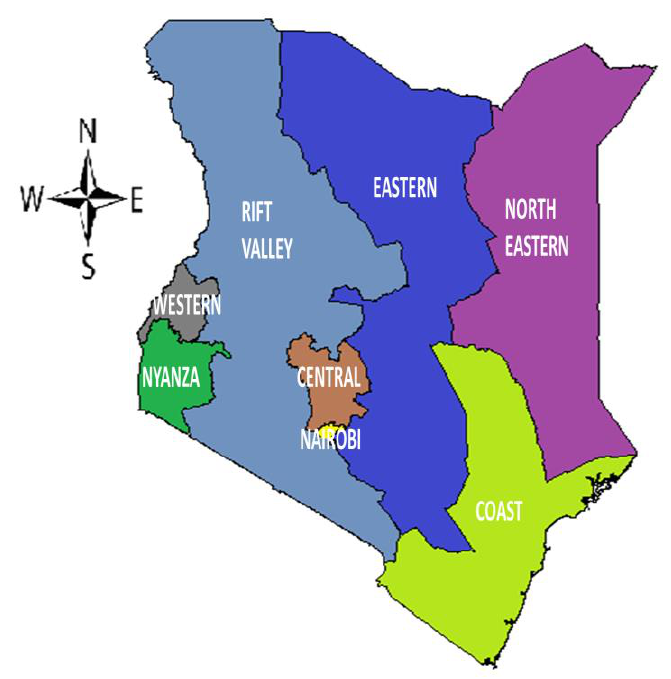
Figure 1. Map of Kenya showing the eight administrative regions.